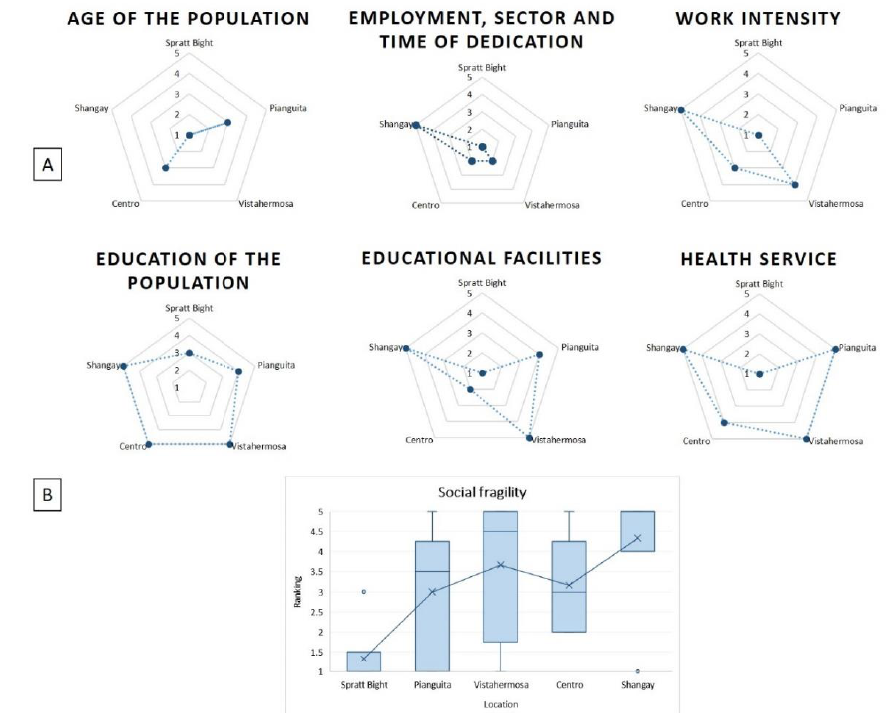
Figure 9. ( A ) Ranking of four variables representing social fragility for two study areas (and five villages): San Andrés, Caribbean Coast (Spratt Bight) and La Bocana, Pacific Coast (Pianguita, Vistahermosa, Centro, Shangay) of Colombia. ( B ) Minimum and maximum values of social fragility for each village and average rank. Results are shown by ranking, given that units of analysis are rank levels and not segments, as was the case for hazard.